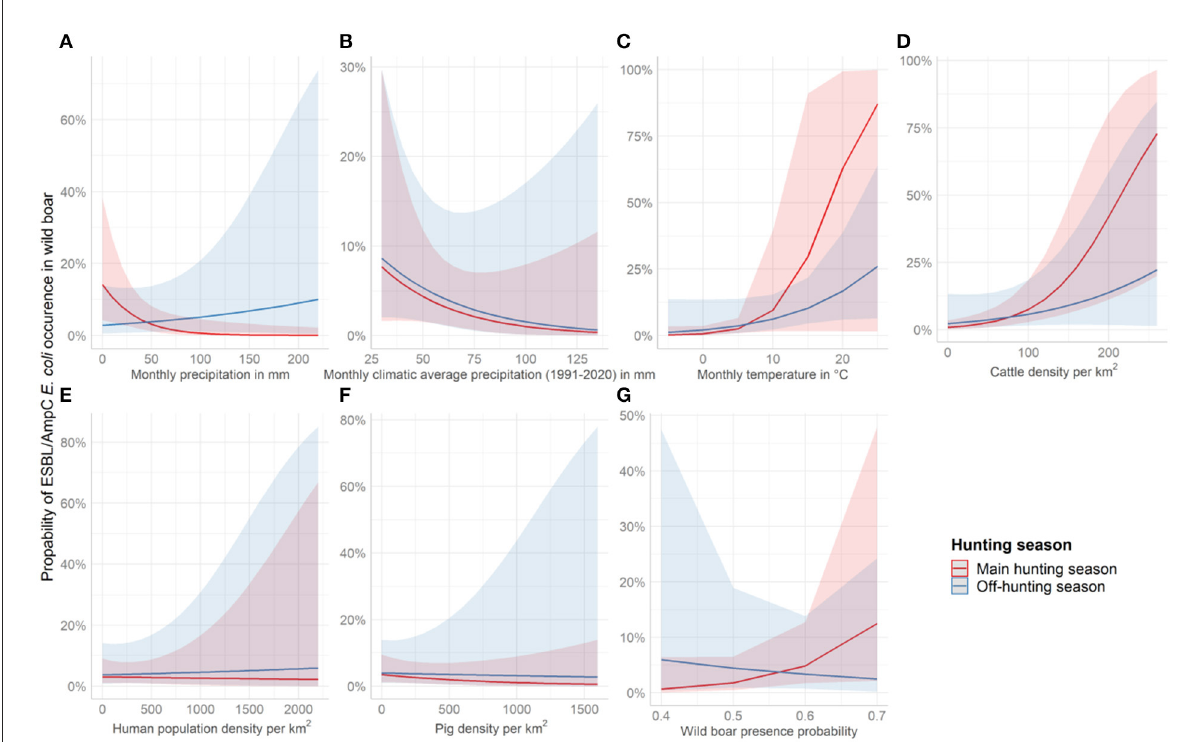
FIGURE4 Effect plots showing the increase or decrease in the probability to identify ESBL/AmpC E. coli in wild boar per covariate and season. The red line represents the course of the main hunting season and the blue line the course of the off-hunting season. The covariates shown are (A) average monthly precipitation 2016 and 2020 in mm, (B) average monthly climatic precipitation (1991-2020) in mm, (C) average monthly temperature of 2016 and 2020 in ◦ C, (D) cattle density per km 2 , (E) Human population density per km 2 , (F) pig density per km 2 , and (G) wild boar abundance.